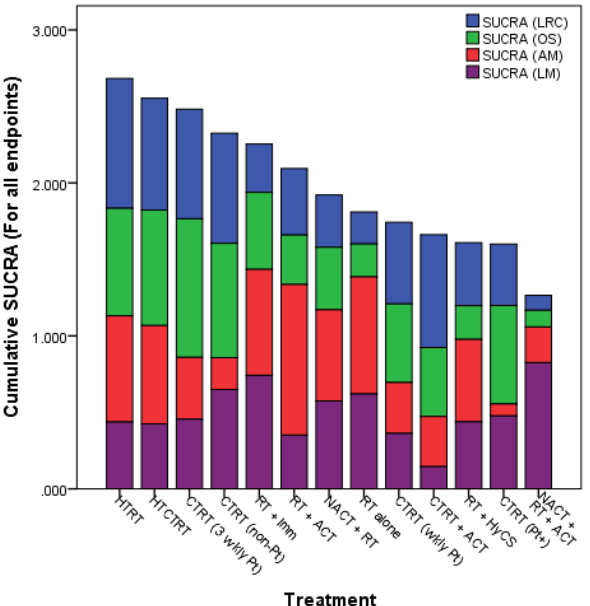
Figure 4. Surface under the cumulative ranking curve (SUCRA) values for endpoints from all stud- ies (1974–2018) in locally advanced cancer cervix. LRC = loco-regional control; OS = overall survival; AM = acute morbidity (grade ≥ 3); LM = late morbidity (grade ≥ 3) (Reproduced with permission from Datta et al. [24]).